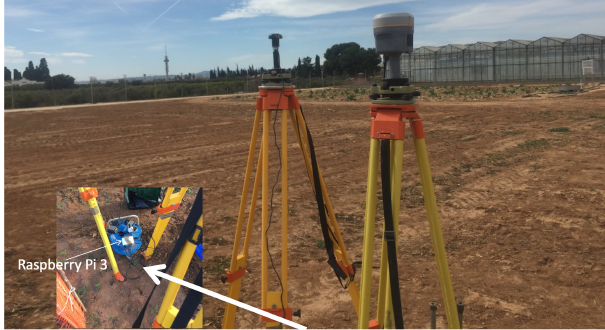
Figure 3. Instrumental configuration in the field campaign. A geodetic-quality GNSS antenna and a mass-market GNSS antenna were working at the same